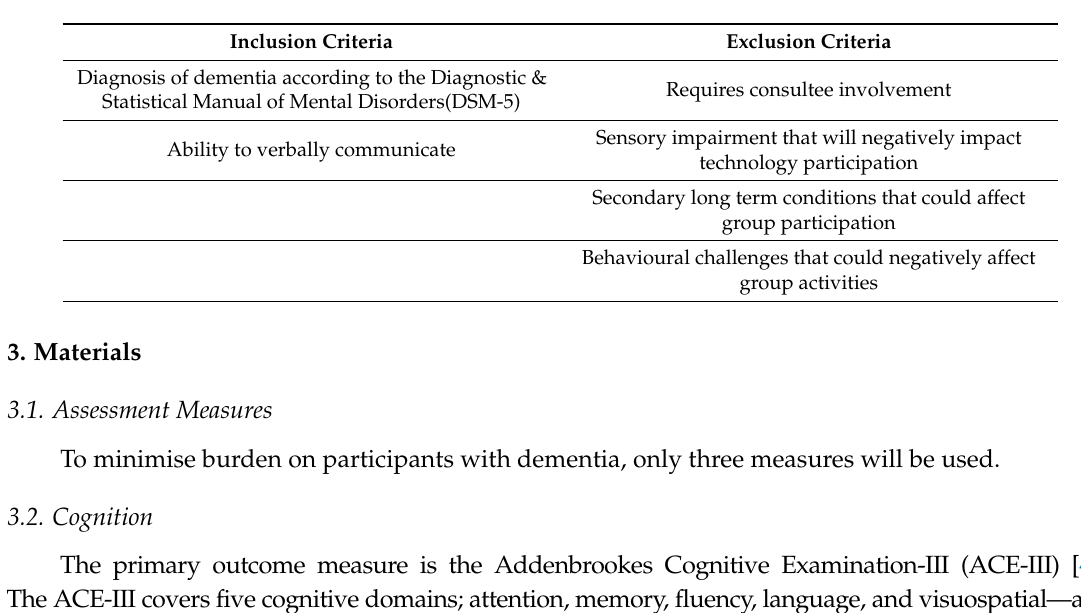
Table 1. Inclusion/exclusion criteria people living with